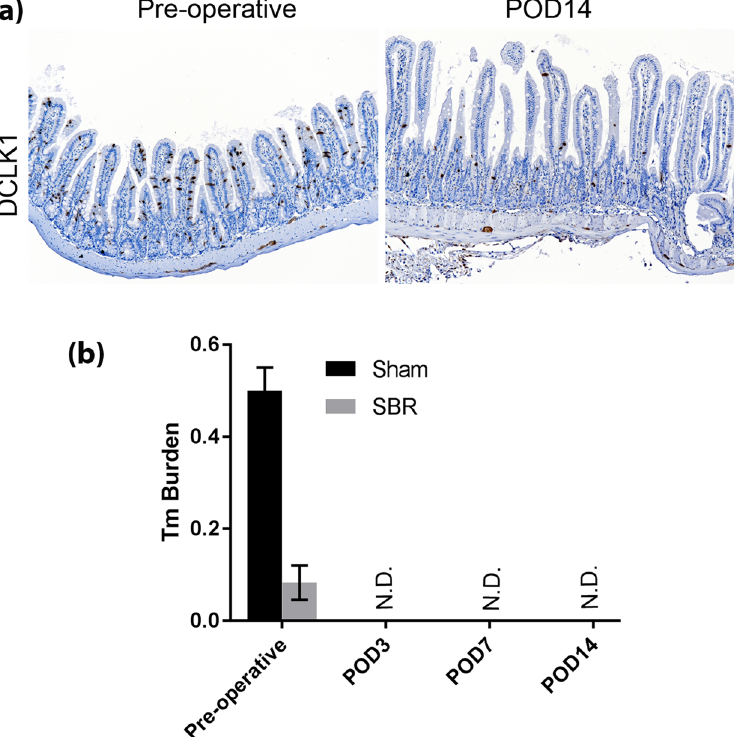
Figure 3. liquid diet is sufficient to eliminate Tm in mice. Vilin-Cre ER ( − ) ; Raptor (f/f) ( WT , n = 4 per group) mice were subject to 50% proximal SBR or Sham operation, small intestinal tissue and stool was collected at the time of surgery and different days after surgery as indicated. ( a ) Representative IHC shows tuft cells in brown using anti-DCLK1 antibody. POD14 indicates postoperative day 14. ( b ) Real-time PCR quantification of Tm burden in collected stool as